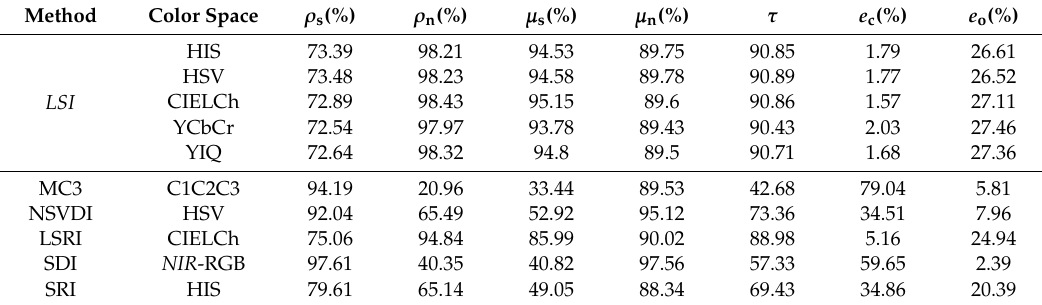
Table 2. Shadow detection accuracy measurements of various shadow detection algorithms for the test image